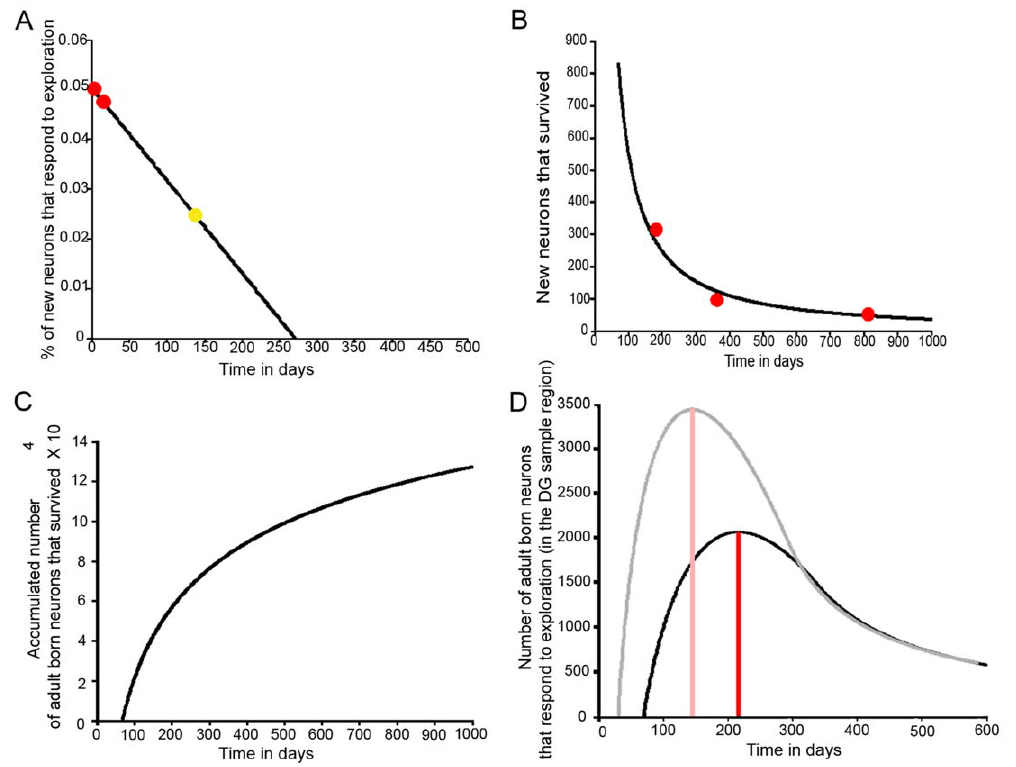
Figure 5. Contribution of adult-born neurons to spatial information processing: a hypothesis suggested by integrating our current data with that obtained previously. A) Linear regression plot calculated using the percentage of BrdU-positive cells that specifically respond to spatial exploration by expressing Arc from animals sacrificed on days 30 and 45 PBI (red dots), and those sacrificed 150 days PBI (yellow dot) [2]. Using this model we calculated the maximum length of time throughout the life span of the animal during which adult-born neurons respond to spatial exploration (time in days means age of animals in X axis for all graphs). The result suggests that after 301 (271 + 30) days, the neurons born in the adult brain may no longer respond to spatial exploration. B) The data obtained from Kuhn [29] was scaled to fit our BrdU-positive cell proportions, and a power model was used to calculate the number of neurons that survived at the different times through the animal’s life. C) Cumulative number of new neurons that survived after 30 days including all the neurons born since 70 days post natal, when the animal is already mature. D) Total number of neurons born after DG development that contributes to the DG spatial exploration response over the course of the animal’s life span. The red line shows the time (day 217) when the maximum number of newly incorporated neurons participates in the DG network response to spatial information processing. At this time, 2057 new neurons respond to spatial exploration, which represents 60% of the total DG granular cell population that responds to spatial exploration. The super-imposed graph (shown in light colors) represents the same calculation including the number of neurons born since postnatal day 1 that survive for 30 days. Notice in particular that the contribution to spatial information processing of neurons born after the DG development is complete increases through the early age of the animals, and after reaching its maximum, it rapidly decreases to a plateau reached in late adulthood. The number of new granular neurons found 45 days after birth in the sampled regions was 345. Adult-born neurons that survived for 4 weeks remained stable for at least 11 months [8]; therefore, we can assume that the number of newly incorporated neurons detected at days 30–45 PBI represents the number of cells born on day 1 that will survive for the rest of the animal’s life. However, the rate of cell proliferation varies across the animal’s life span [29], and this modifies the number of stable new neurons throughout the life time.